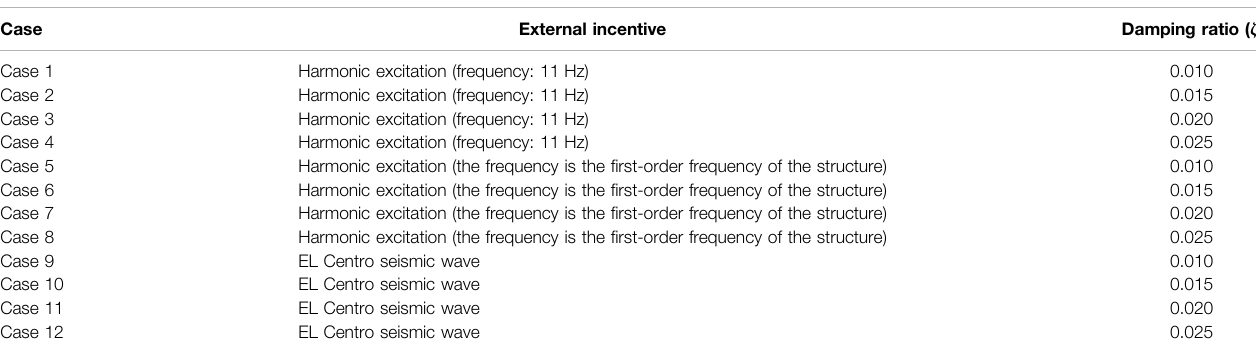
TABLE 2 | Calculation